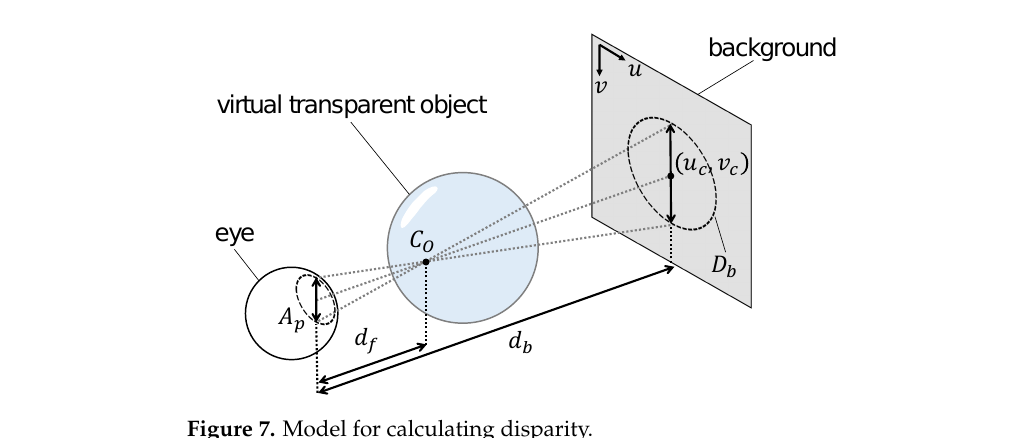
Figure 7. Model for calculating